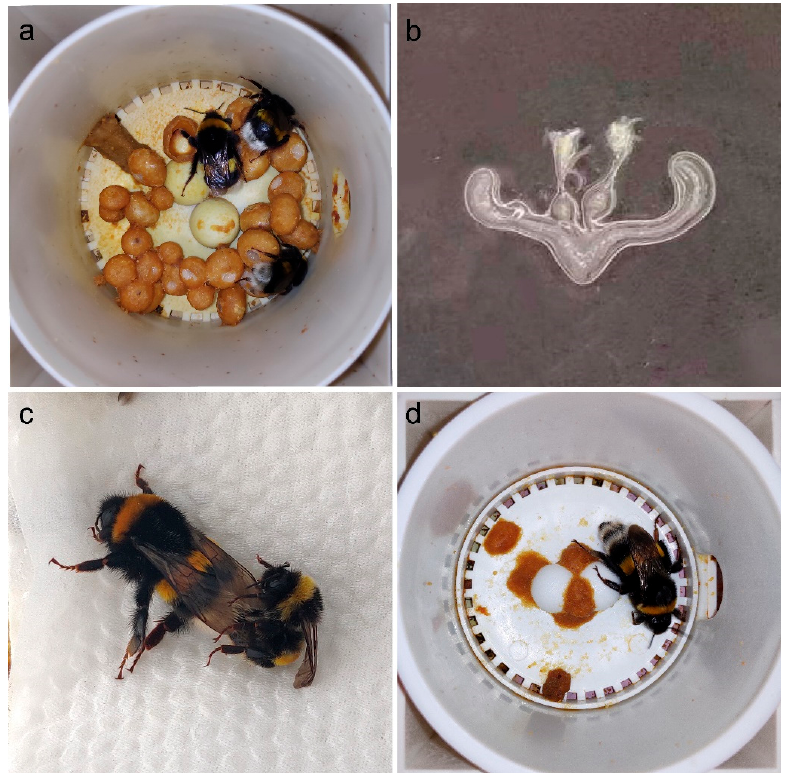
Figure A1. The display of important procedures in the course of the research. ( a ). The rearing of the WMs in queenless micro-colonies who started from three workers with similar age from one colony; ( b ) the accessory testes of male bees under dissection; ( c ) the male and queen were mating, and mating pairs were transferred to separate boxes for observation; ( d ) the mated queens were reared in small boxes after diapause.